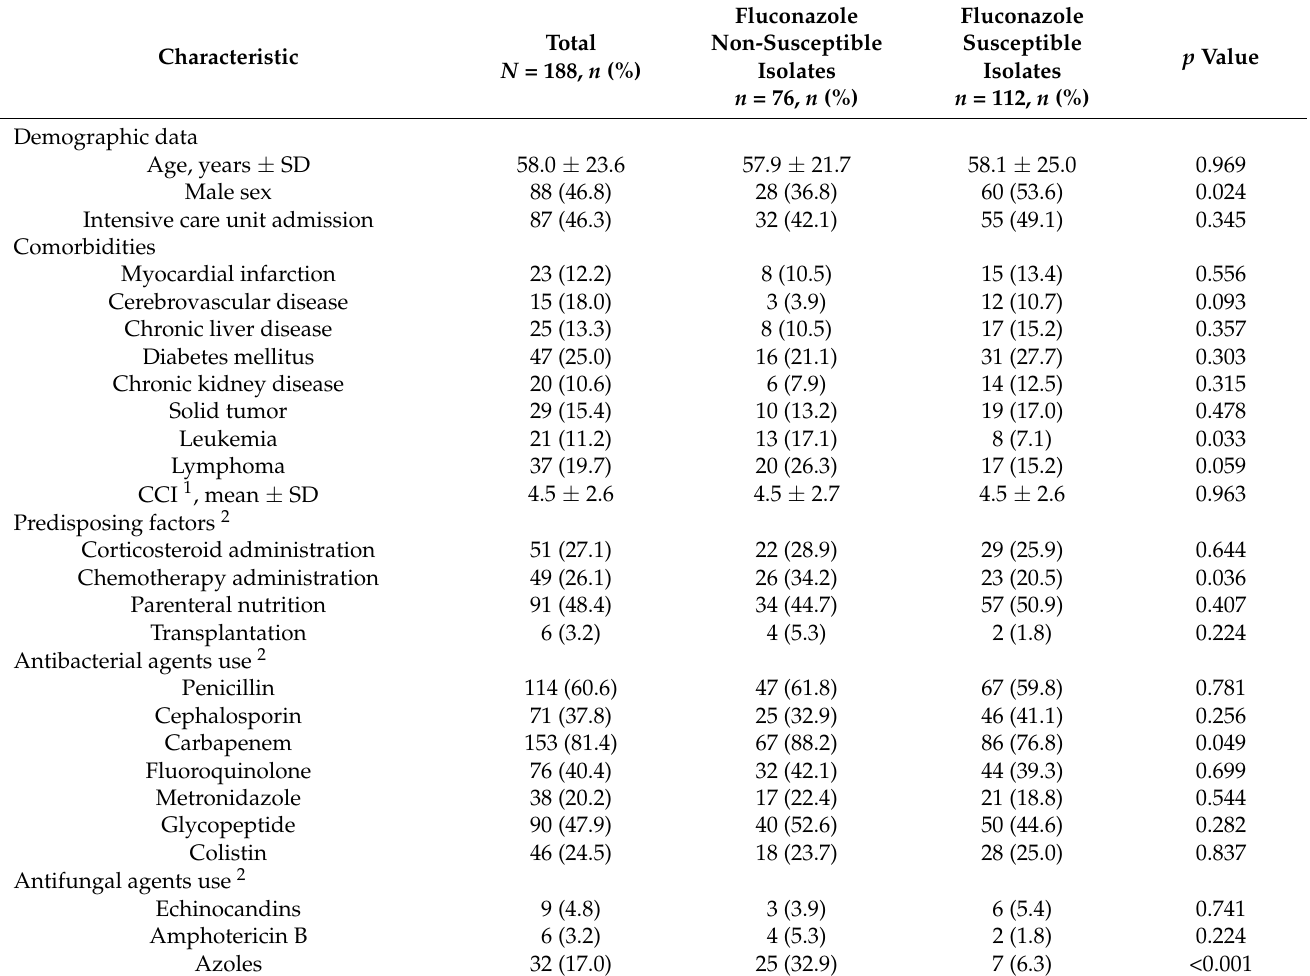
Table 1. Demographic data and clinical characteristics of patients with Candida tropicalis bloodstream